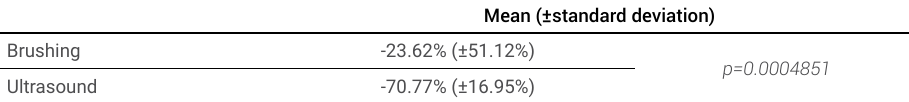
Table 1. Means and standard deviations of percentage change of biofilm biomass.